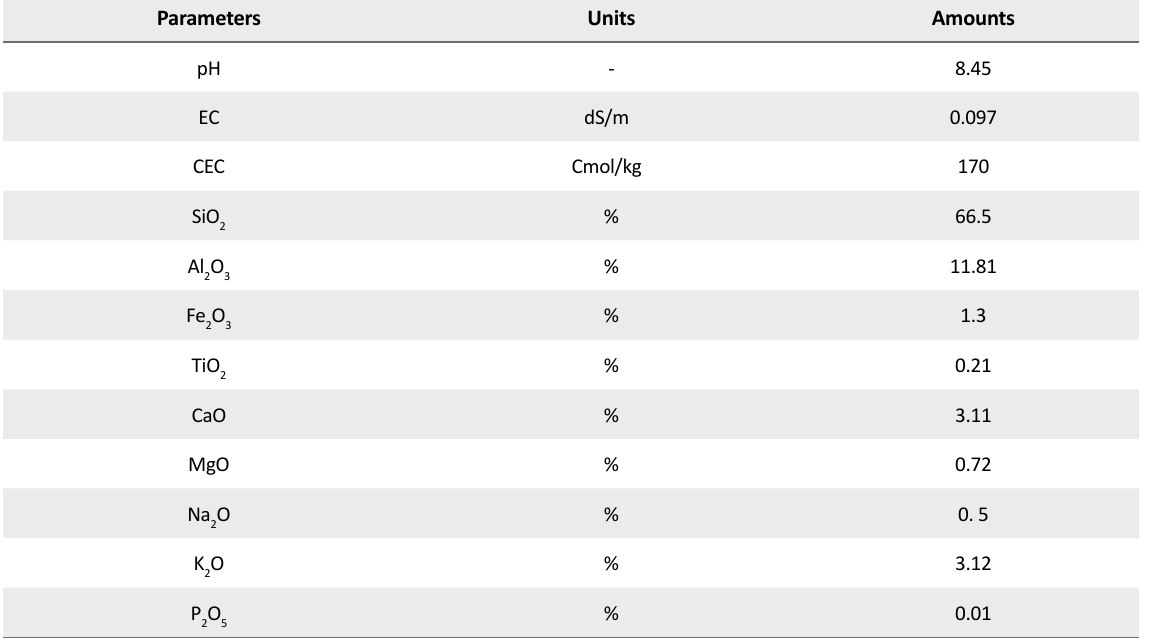
Table 2. The chemical properties of zeolite